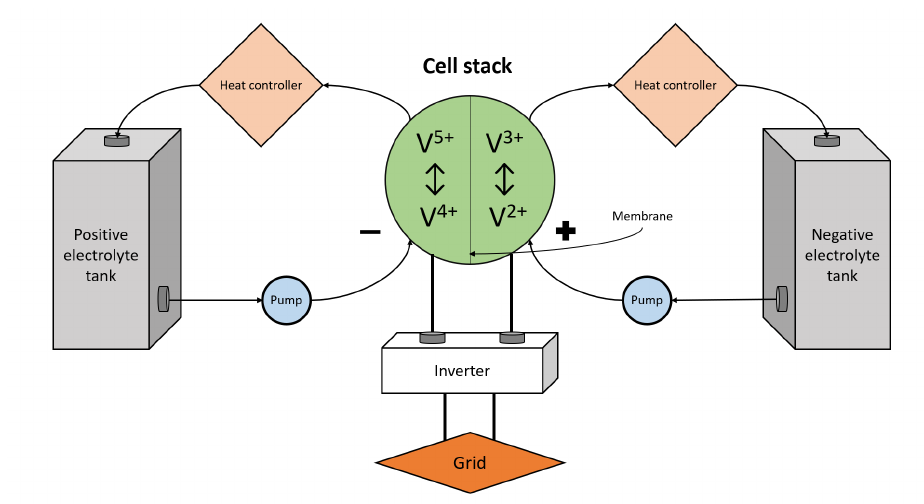
Figure 3. Vanadium redox battery model